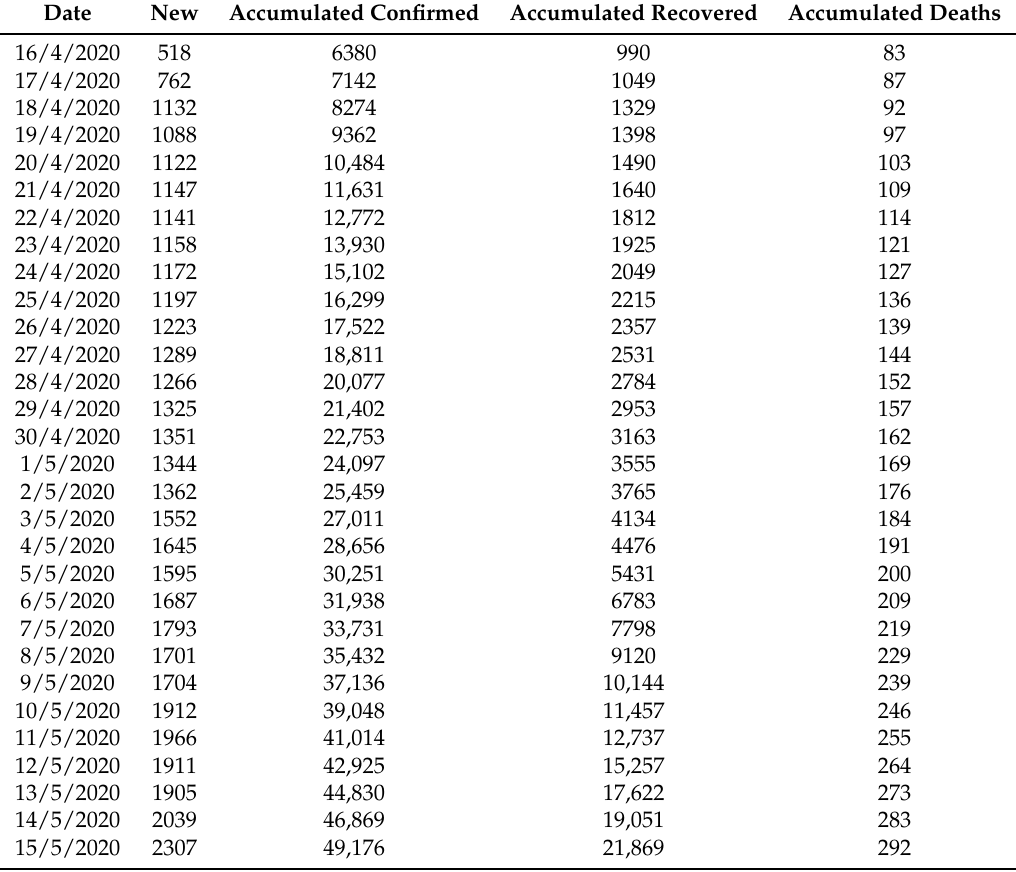
Table 2. Number of cases in Saudi Arabia from 16 April 2020 to 15 May